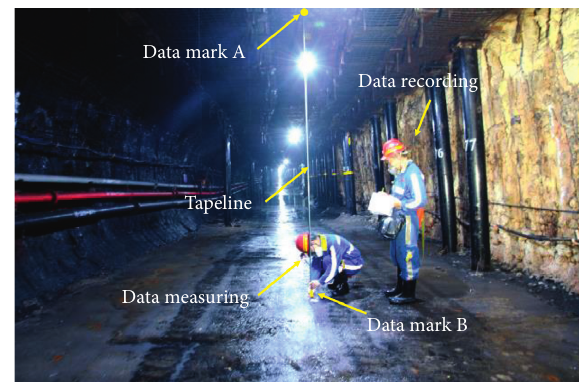
Figure 13: Monitoring method of roof-to-floor deformation.